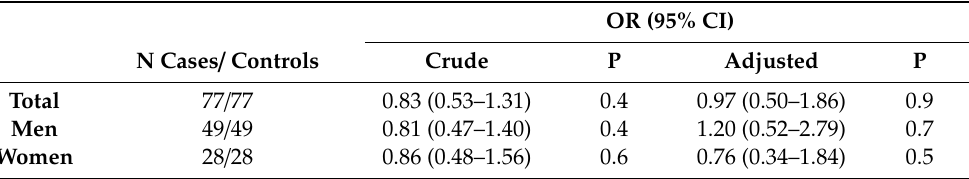
Table 2. Odds ratios and 95% confidence intervals for the association between bilirubin levels and colorectal cancer (CRC) risk in the KORA